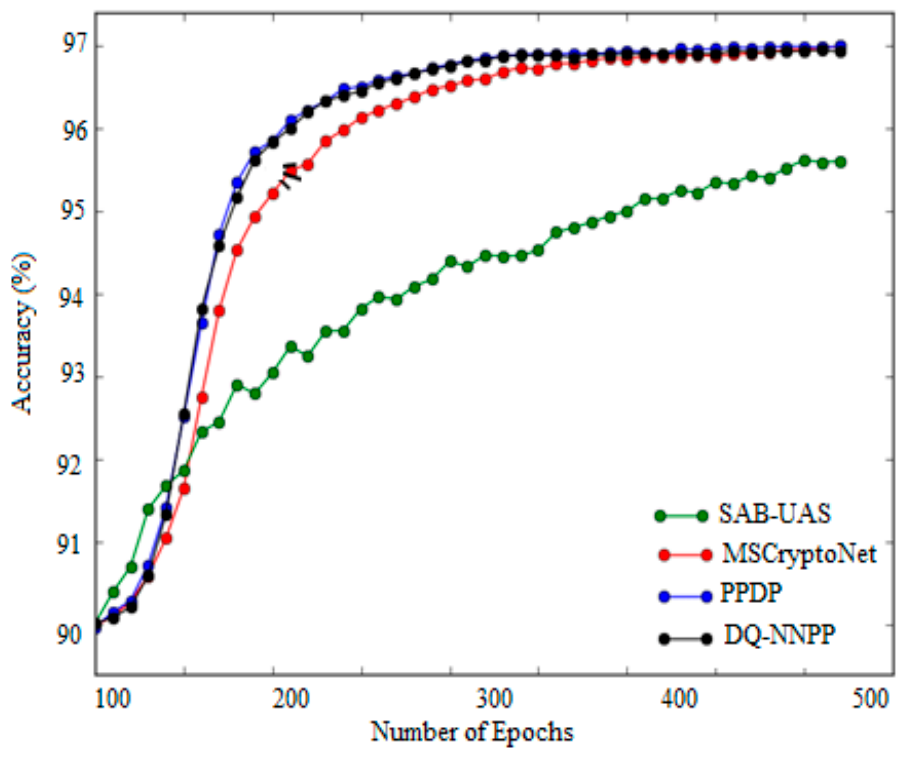
Figure 4. Comparison of accuracy.